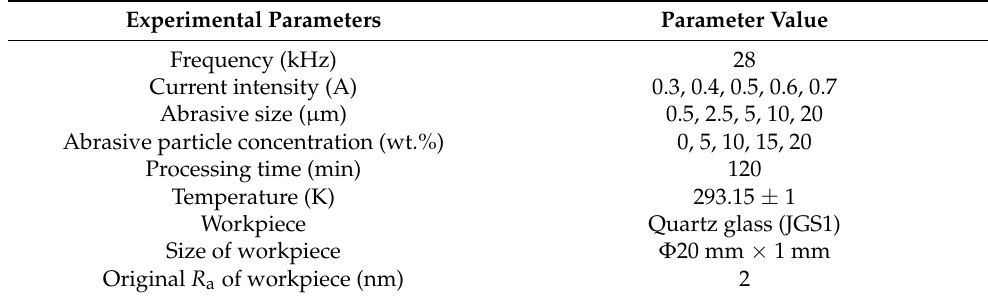
Table 2. Experimental